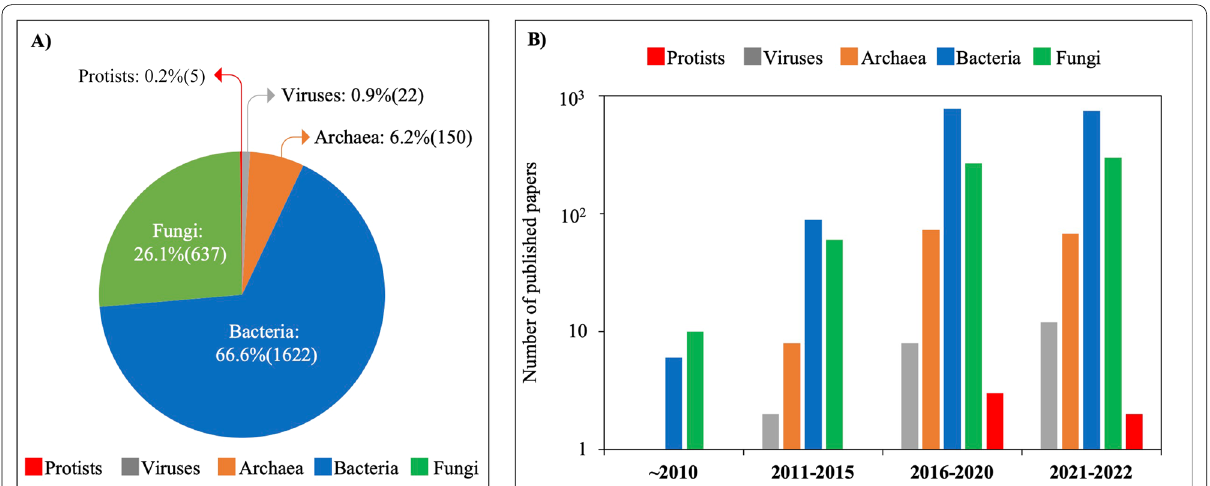
Fig. 1 Comparison of published biochar studies on protists with those on other microbial groups including viruses (grey), archaea (orange), bacteria (blue), and fungi (green). A) Percentage values of the total studies B) Number of published papers per years. The data represent articles available on Web of Science database. For the search crieteria and terminology of keywords, please see Geisen et al. (2017). It should be noted that the research on biochar production from protists (algae) was not included since the aim of the study is to focus on biochar-protist interaction, rather than biochar production from